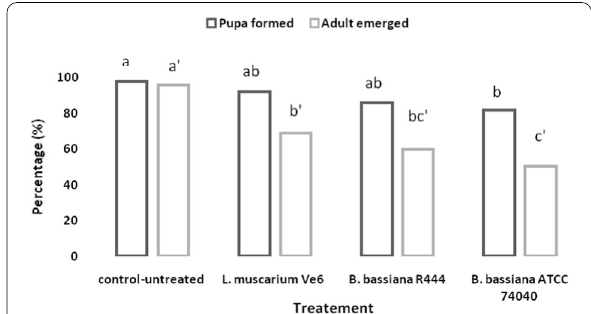
Fig. 5 Effects of commercial entomopathogenic fungi (EPF) preparations on pupation and adult emergence of Tuta absoluta . The means followed by the same letter are not significantly different by the Tukey test (HSD) ( p <